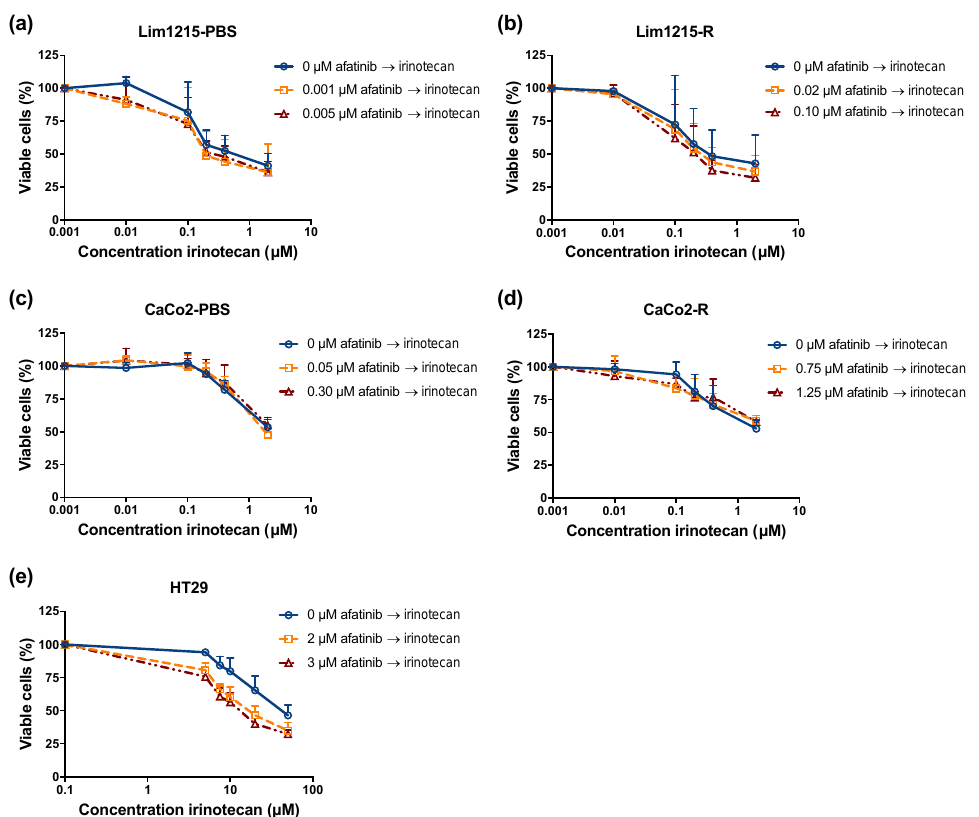
Figure 7. The cytotoxic effect of afatinib followed by irinotecan in CRC cell lines with different sensitivities to cetuximab. Dose–response curves for the cetuximab-sensitive ( a , c ), corresponding isogenic acquired cetuximab-resistant ( b , d ), and intrinsically cetuximab-resistant ( e ) CRC cell lines indicate an additive effect. Survival curves are corrected for the cytotoxic effect of 72 h of afatinib alone. Cells were treated with fixed concentrations afatinib, which were based on the outcome of the monotherapy experiments.